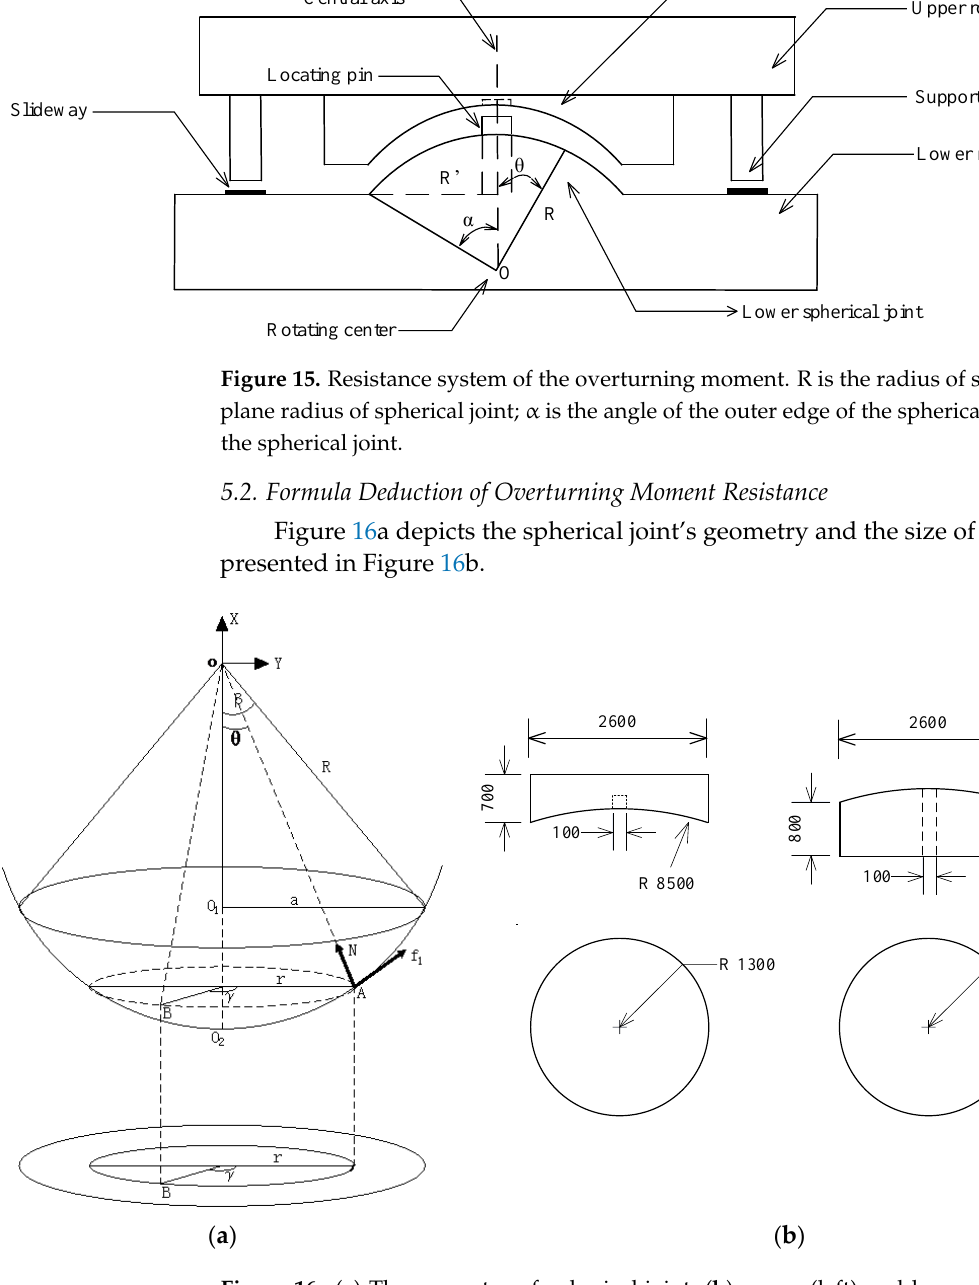
Figure 16. ( a ) The geometry of spherical joint; ( b ) upper (left) and lower (right) spherical joints (unit: mm).